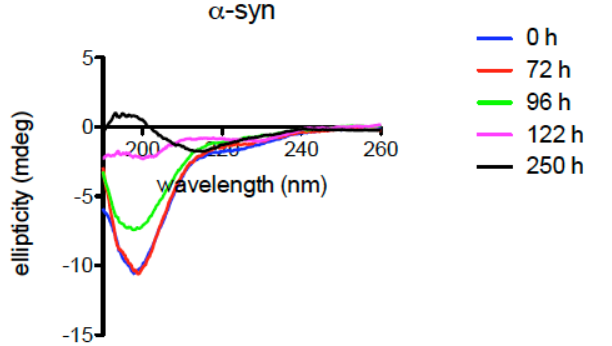
Figure 8. CD spectra of Xenopus α -syn. The protein (10 µ M) in 10 mM potassium phosphate buffer pH 7, containing 50 mM Na 2 SO 4 , was incubated at 37 °C for the specified times.